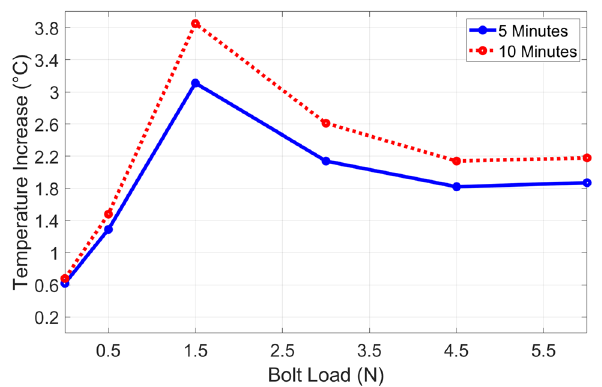
Fig. 20 Maximum temperature increase (°C) in the topmost inter- face recorded at five and 10 min after the electrodynamic shaker was turned on